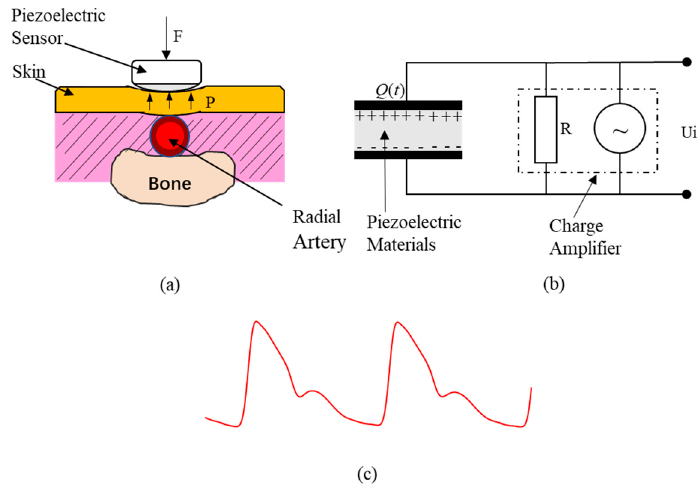
Figure 1. PPW measurement based on piezoelectric sensor. ( a ) Pressure pulse wave (PPW) measurement. ( b ) Pressure conversion of an electric signal model of a piezoelectric sensor. ( c ) PPW signals in radial artery.